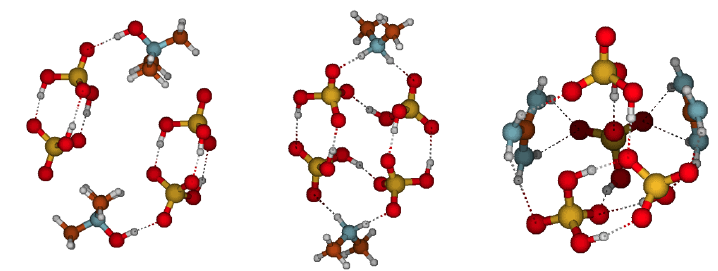
Figure 11. Molecular structures of 4SA2TMAO ( left ), 4SA2DMA ( middle ), and 4SA2GUA ( right